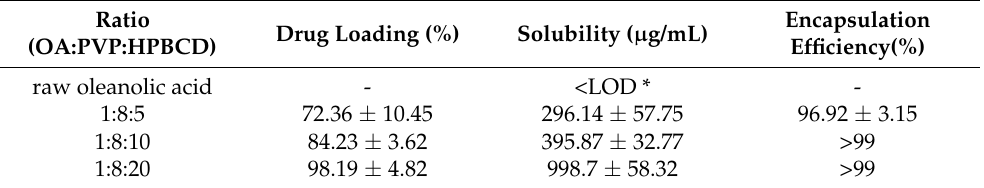
Table 3. Drug loading, encapsulation efficiency, and water solubility of different formulations of OAnf. Results are shown as mean ± SD of three independent